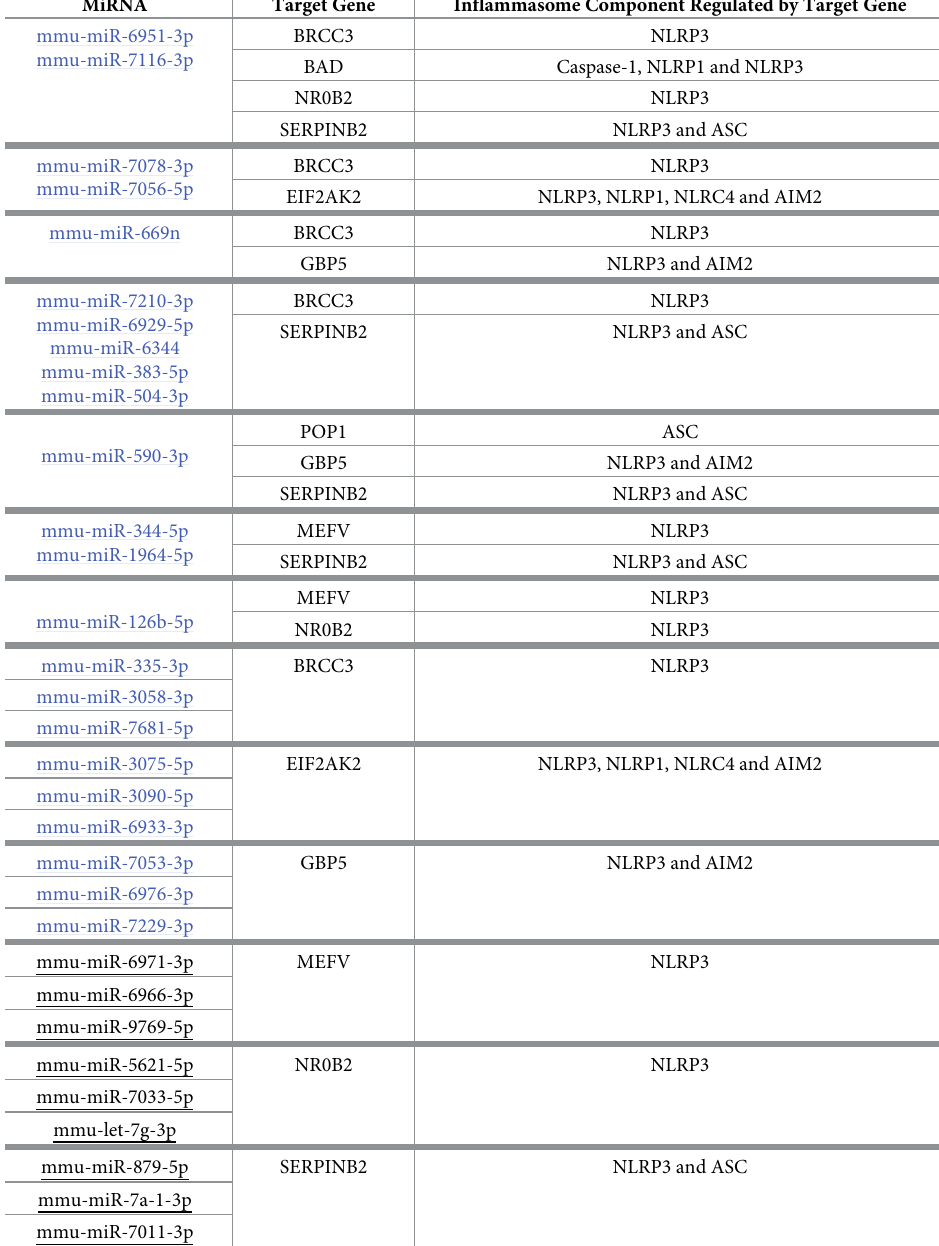
Table 1. miRNAs predicted to target some of the known regulators of inflammasomes. Information obtained from miRDB, an miRNA target prediction and functional annotation database, which uses the bioinformatics tool, MirTarget. Target scores below 60 were excluded from the analysis as they indicate low confidence in the prediction